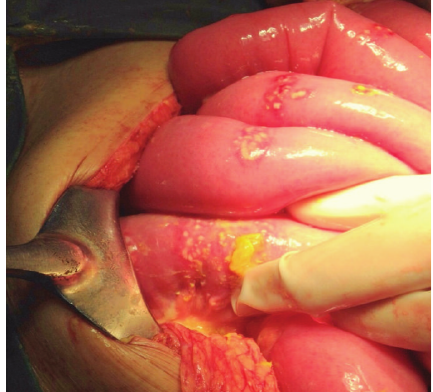
Figure 4: Primary closure of most of